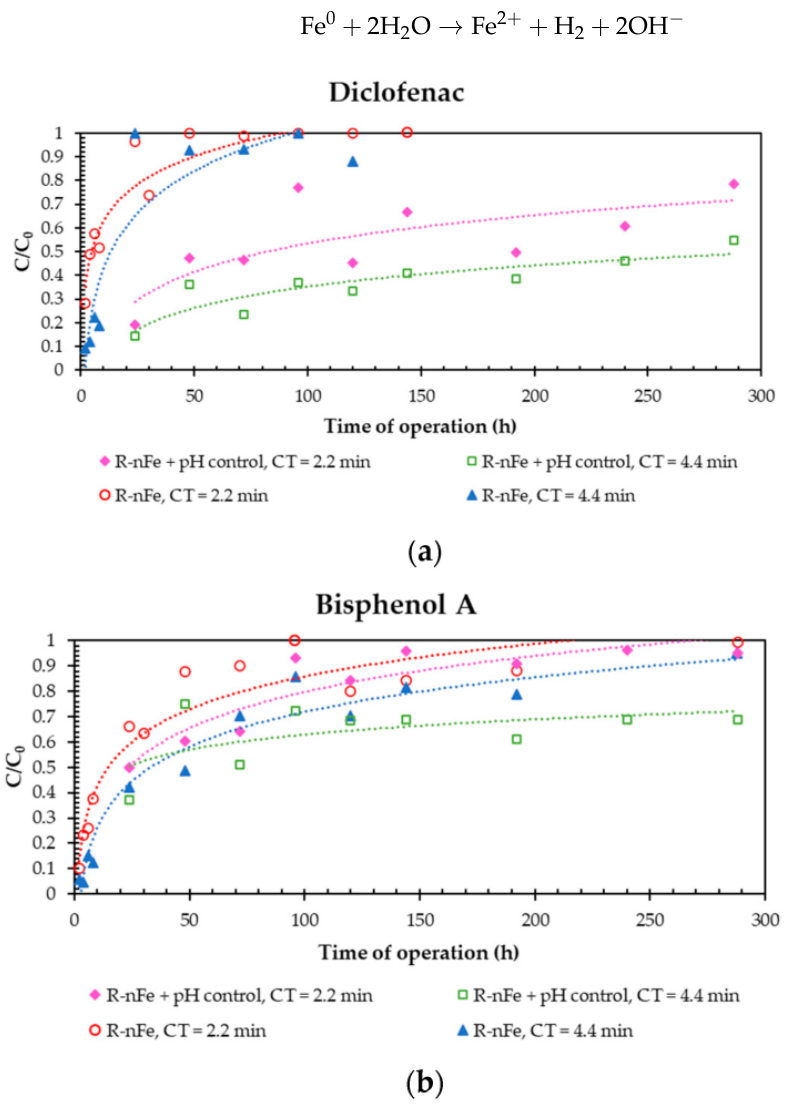
Figure 4. Effect of pH adjustment of the influent matrix to acidic values (approximately 3.5) and effect of contact time under acidic conditions on the removal efficiency of diclofenac ( a ) and bisphenol A ( b ) (Q = 26 L/d, C 0 = 5 µ